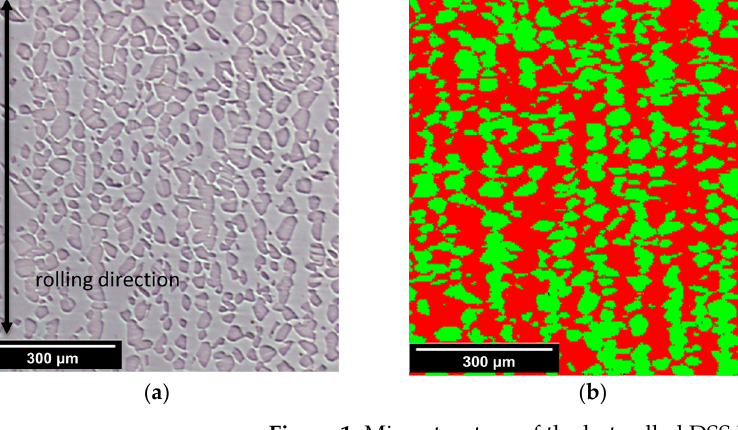
Figure 1. Microstructure of the hot-rolled DSS X2CrNiMoN22-5-3 after heat treatment. ( a ) Optical microscope image (bright gray: ferrite, dark gray: austenite), ( b ) EBSD phase map (red: ferrite austenite, green: austenite), ( c ) BSE-SEM image and the corresponding EDX mapping of the elements Ni, Cr and Mo. (bright gray: austenite; dark gray: ferrite).